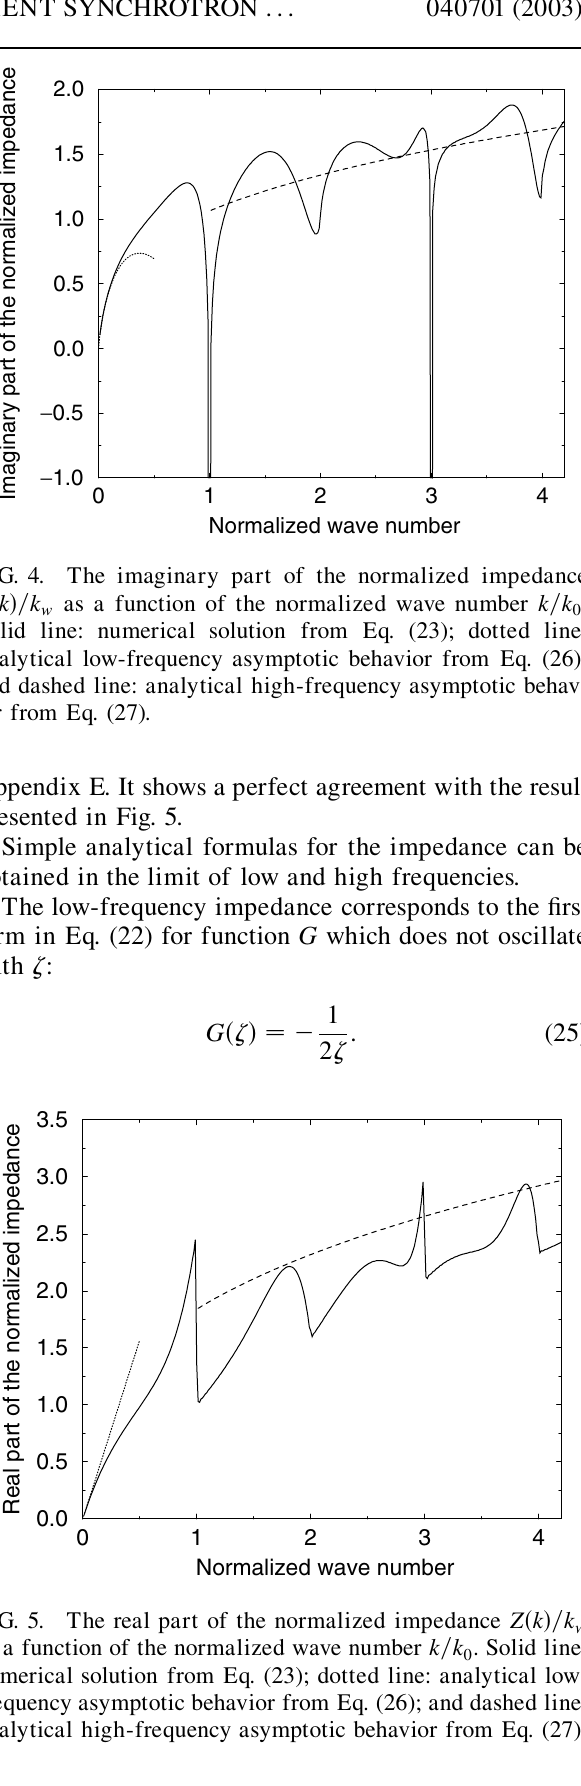
FIG. 3. The normalized wake Green function (cid:6)(cid:9) 2 as a function of the normalized coordinate (cid:2) w (cid:5) s (cid:6)(cid:7) K= (cid:5) (cid:16)k w 2 (cid:22)=(cid:18) .